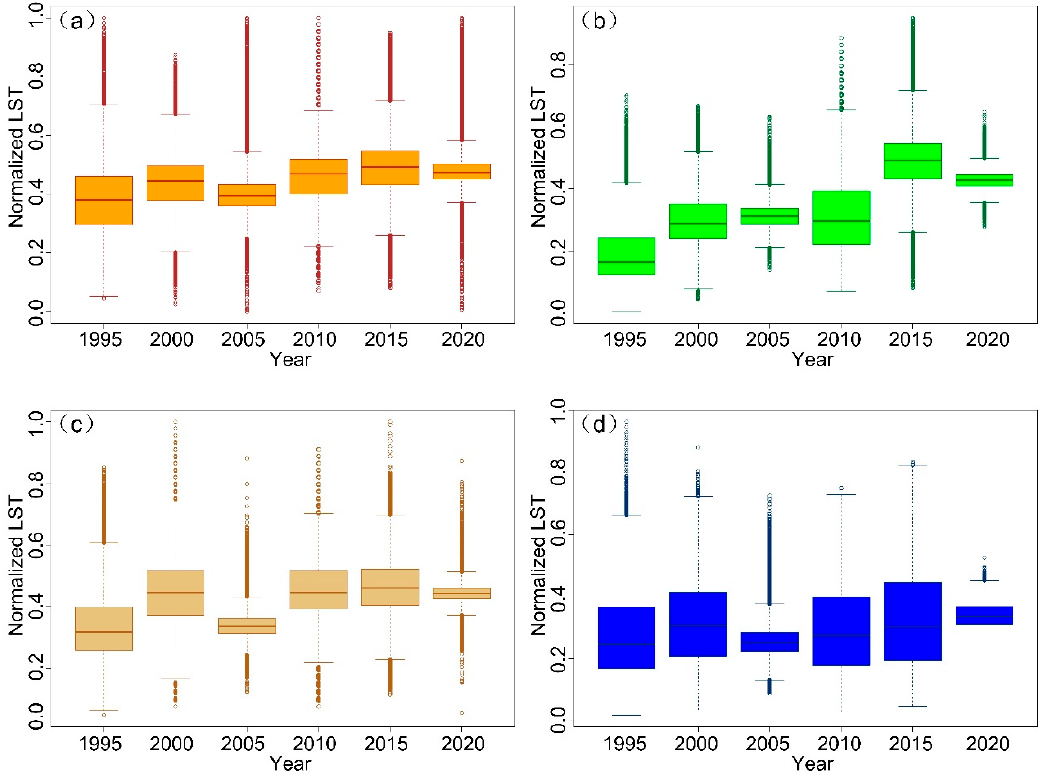
Figure 4. Box plots of normalized land surface temperature for different land cover types. ( a ) Built-up area, ( b ) green space, ( c ) bare land, and ( d ) water.